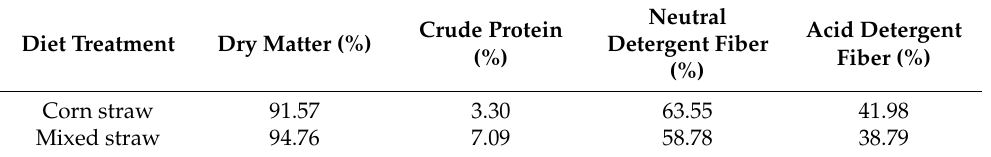
Table 1. Nutrient composition of roughage (after air